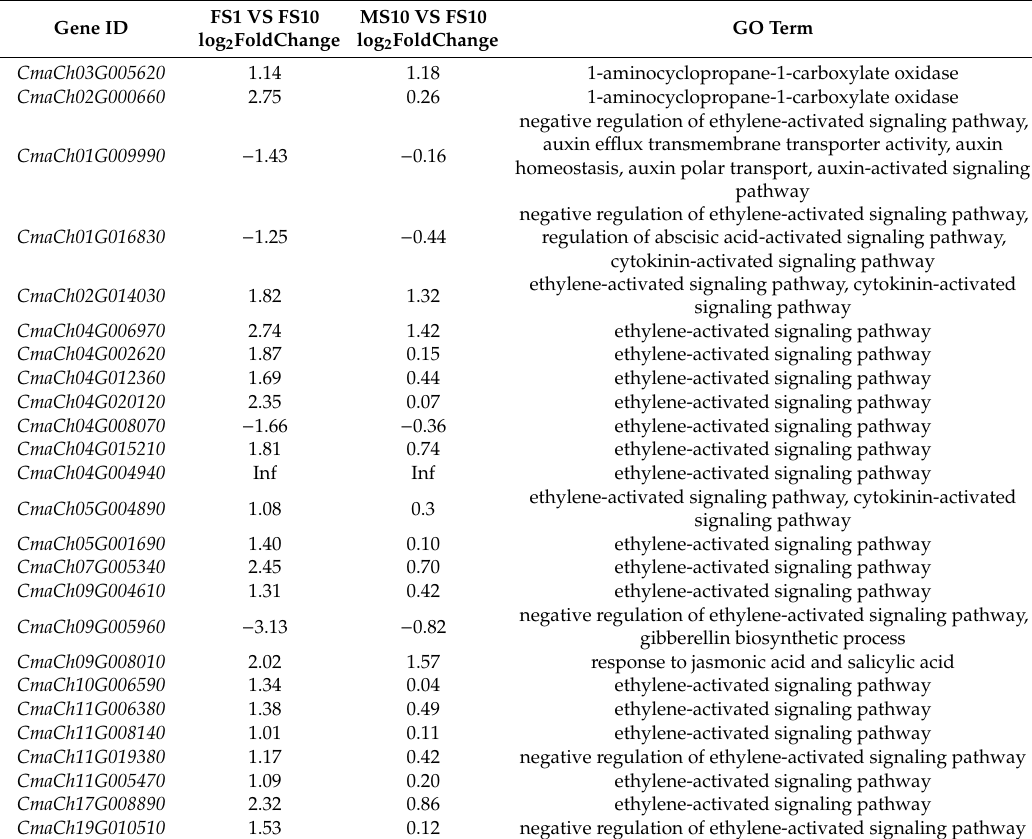
Table 2. Di ff erentially expressed genes related to ethylene synthesis and signal transduction in one-‘2013–12’ one-true-leaf stage sample (FS1) vs. 10-leaf stage sample (FS10) and ‘6–9’ one-true-leaf stage (MS10) vs.